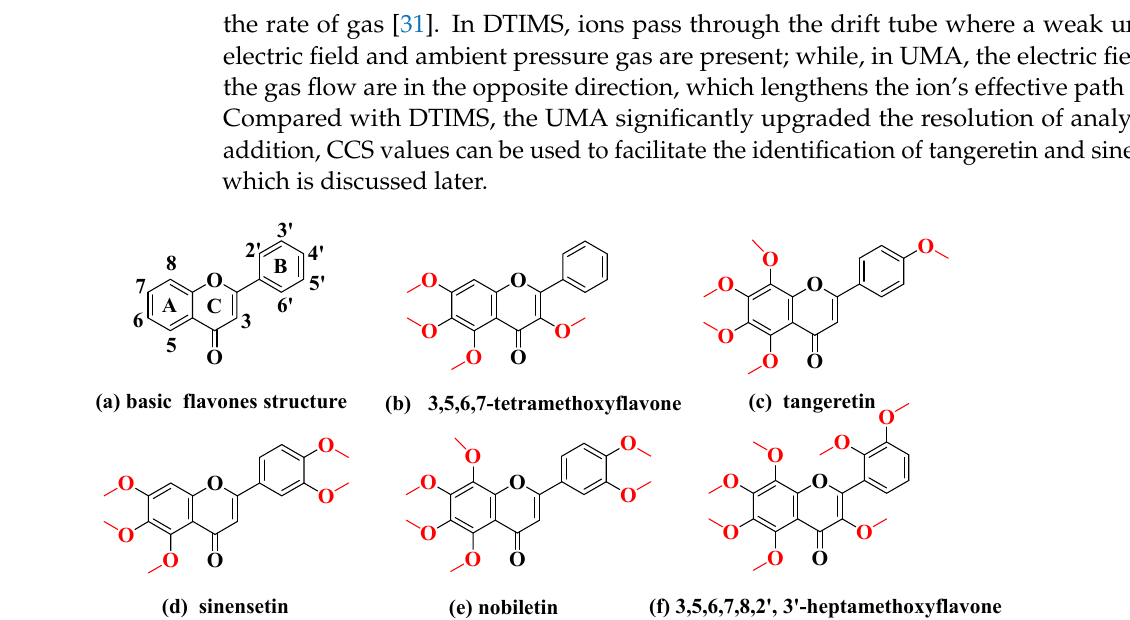
Figure 3. MS spectra ( a ) and UMA spectra ( b ) of five polymethoxylated flavones in Chenpi MS spectra of a, (1) 3,5,6,7- tetramethoxyflavone, (2) tangeretin and sinensetin, (3) nobiletin, (4) 3,5,6,7,8,2 ′ ,3 ′ -heptamethoxyflavone. UMA spectra of b, (1) 3,5,6,7-tetramethoxyflavone, (2) tangeretin and sinensetin, (3) nobiletin, (4) 3,5,6,7,8,2 ′ ,3 ′ -heptamethoxyflavone. The x-axis represents CCS values and Y-axis represents relative abundance.